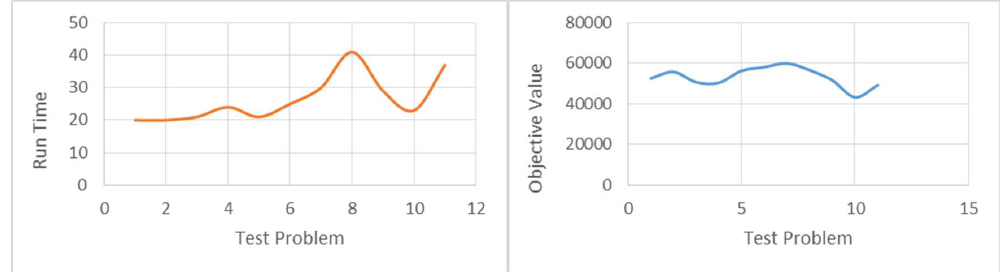
Fig. 11. Objective value and run time for scenario 2